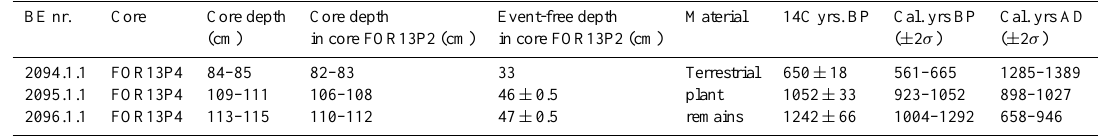
Table 1. Radiocarbon dates of core FOR13P4. We calculated the event-free sedimentary depth by removing the graded beds, which were considered to be instantaneous deposits. See text for explanation, nature of samples and calibration procedures. BE nr.